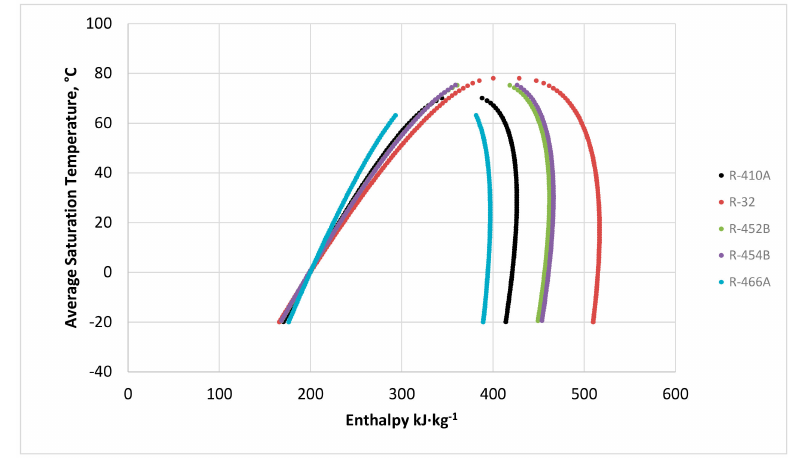
Figure 1. Temperature-enthalpy plots of refrigerant R410A and alternatives.